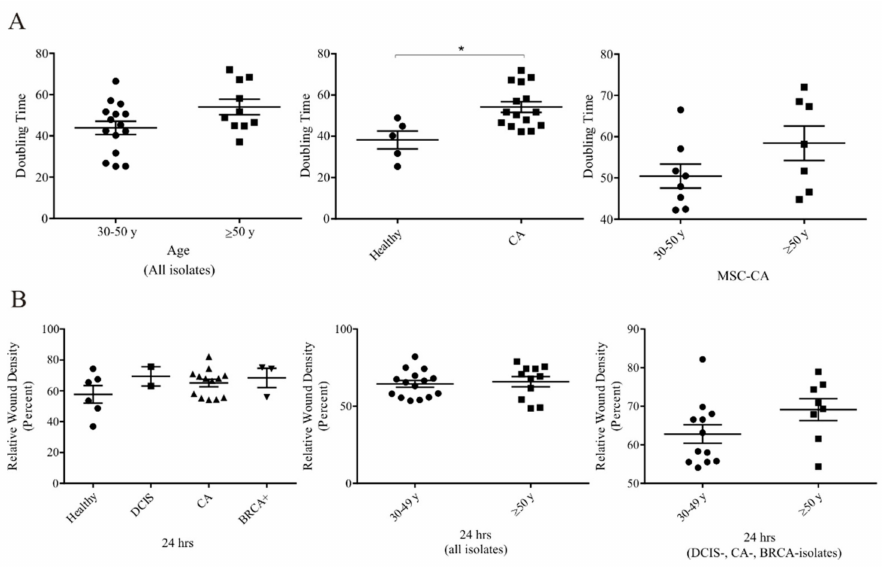
Figure 3. Functional changes in cancer patient adipose tissue-derived MSCs ( A ) Left: MSC doubling-time in all MSC isolates had increasing tendency in older donors, but this tendency was not statistically significant. Middle: Based on the diagnosis of MSC donors, we observed significantly longer doubling-time in MSCs isolated from patients with invasive cancer compared to healthy MSCs (* p < 0.05; Mann-Whitney test). Right: The trend of increased doubling-time was present also in the MSC-CA group. ( B ) MSC migration potential analysis based on diagnosis (left), age in all MSC groups (middle) or age in solely cancer patients (right) showed no statistically significant di ff erences. MSCs used for analysis did not exceed 10th